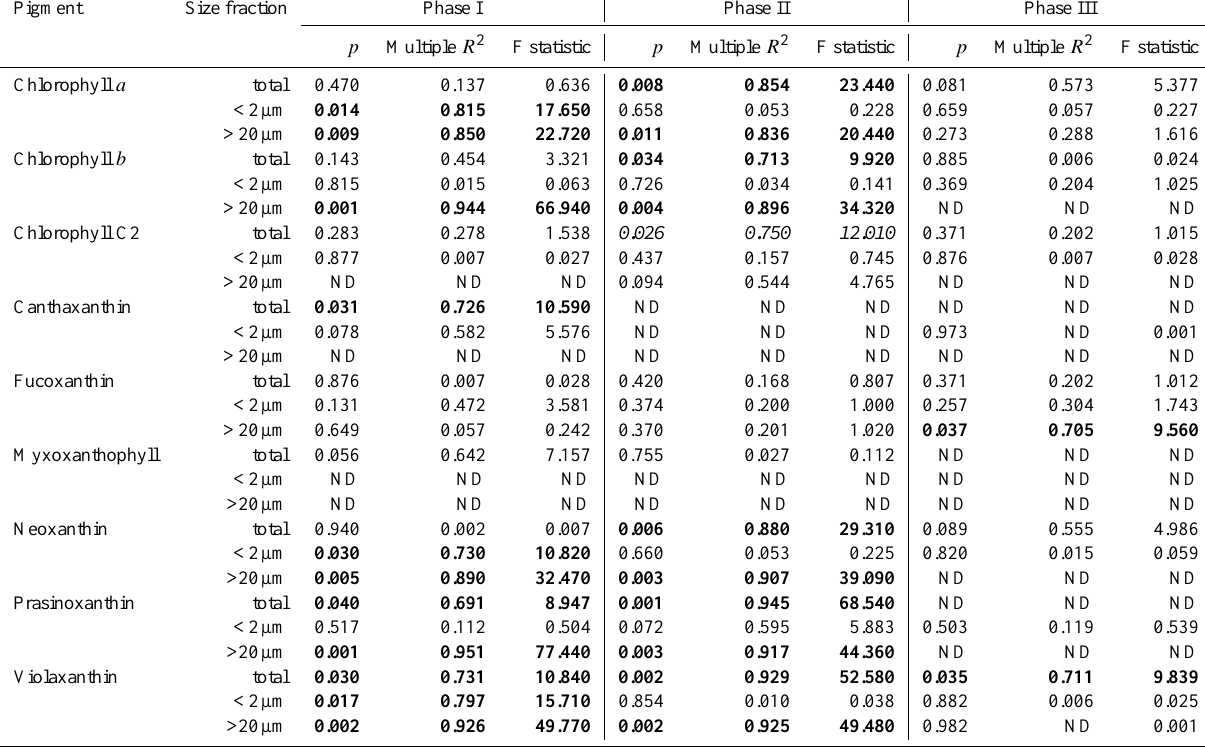
Table 5. Summary of linear regression analyses done on absolute concentrations of phytoplankton pigments for the three experiment phases in different size fractions. Bold indicates significant positive effect and italic indicates significant negative effect of CO 2 concentration. ND indicates pigment was not detected. Where no pigment was detected in any phase in any size fraction, results were not included in this table.